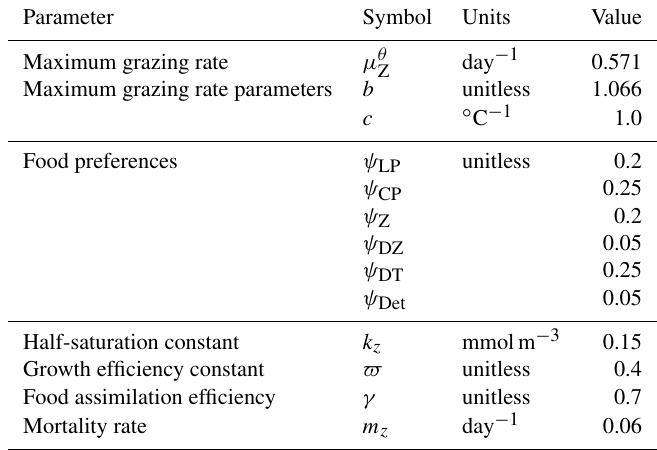
Table 4. KMBM3 zooplankton parameters. Temperature-dependent parameter values are given for 0 ◦